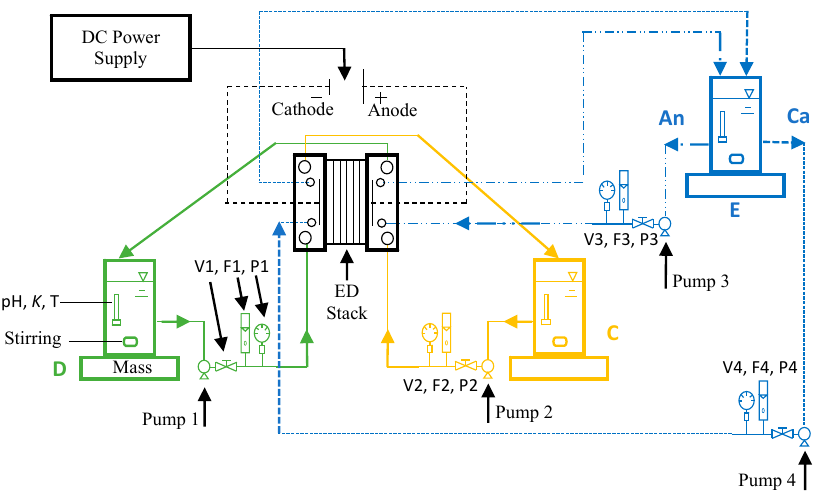
Figure 1. Schematic diagram for the batch-recycle electrodialysis system (adapted from Ref. [10]); K = conductivity, T = temperature; V = valve, F = flow meter, P = pressure gauge, D = diluate stream, C = concentrate stream, E = electrode rinse, An = anolyte, Ca = catholyte.